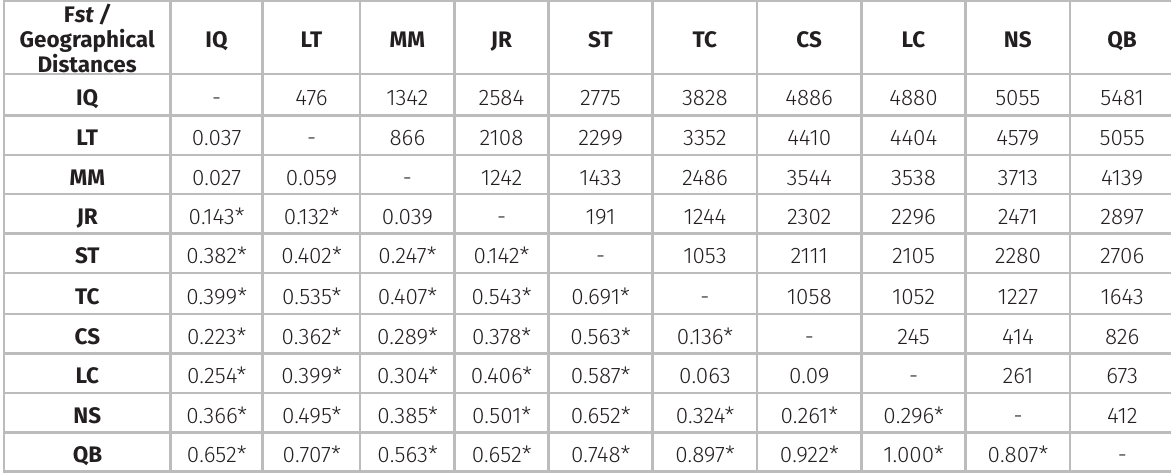
Table II. Genetic differentiation matrix (pairwise Fst) based on the concatenated mitochondrial ( Cytb and Control Region) data set (below the diagonal) and the geographical distances (km) between Arapaima populations. F st / Geographical